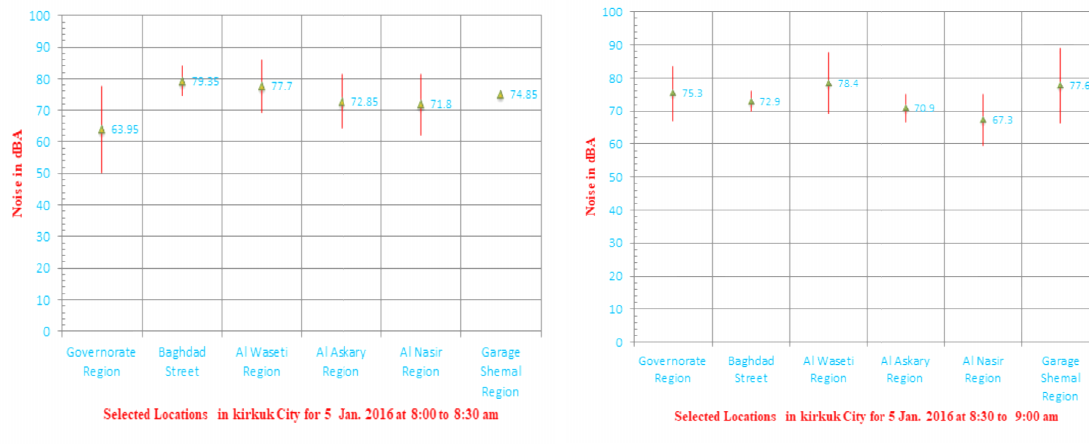
Fig .13. Max, Min and Average Hourly Noise Distribution for the traffic flow 5 Jan. 2015 Kirkuk City.